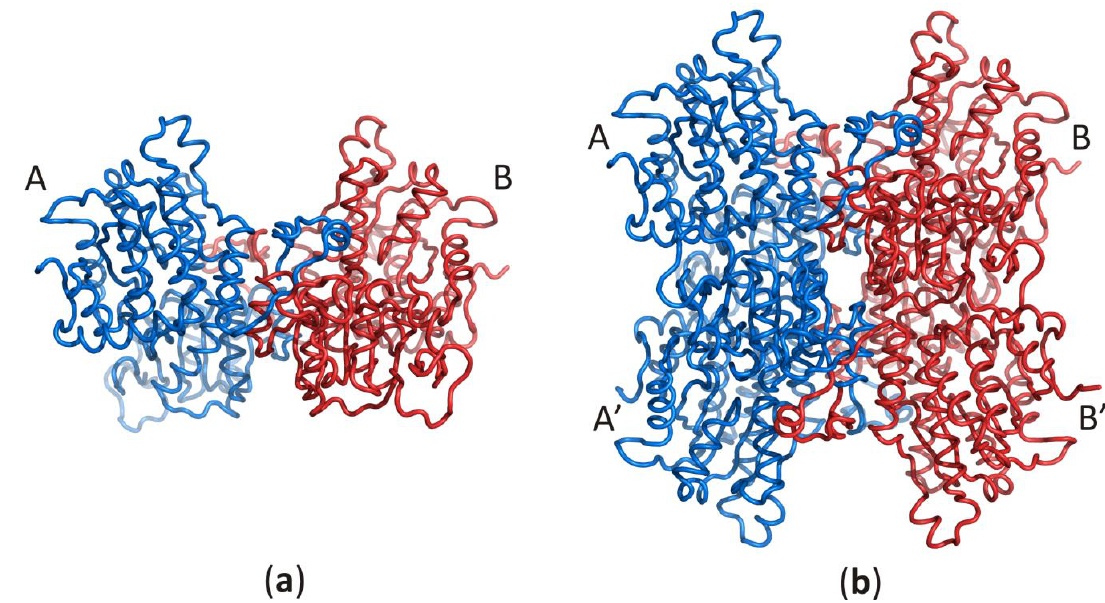
Figure 1. Oligomeric forms of SAHases; ( a ) The AB (or A’B’) homodimer corresponds to the active form of the plant enzyme; ( b ) The dimer of dimers (AB–A’B’) that corresponds to the active form of most SAHases of archaeal, bacterial and eukaryotic origin. The colour code indicates individual subunits: A and A’ (blue), B and B’ (red).